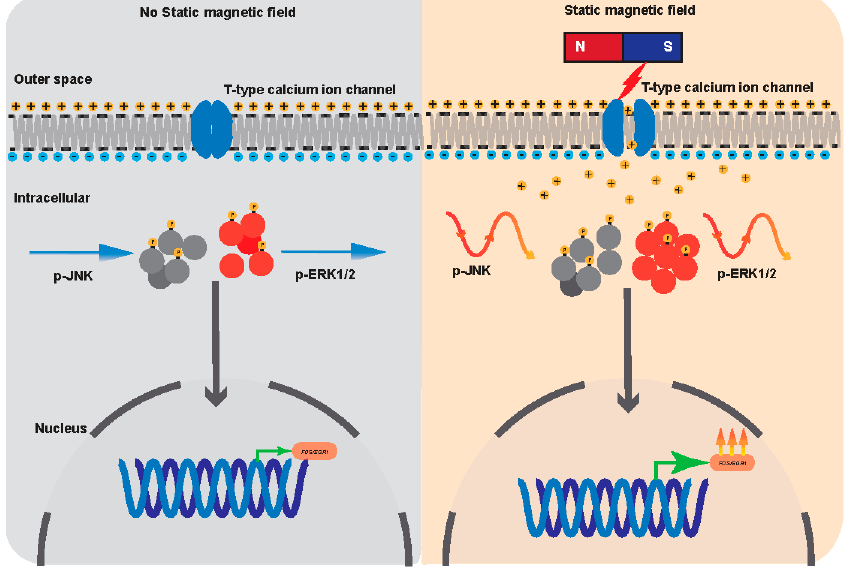
Figure 5. Graphic conclusion. Exposure to SMFs causes membrane depolarization transduced by T-type voltage-gated calcium channels into second-messenger cascades (e.g., ERK, JNK) that regulate downstream gene expression (e.g., FOS , EGR1 , etc.); hence, directing the acceleration of the cell cycle promotes proliferation.